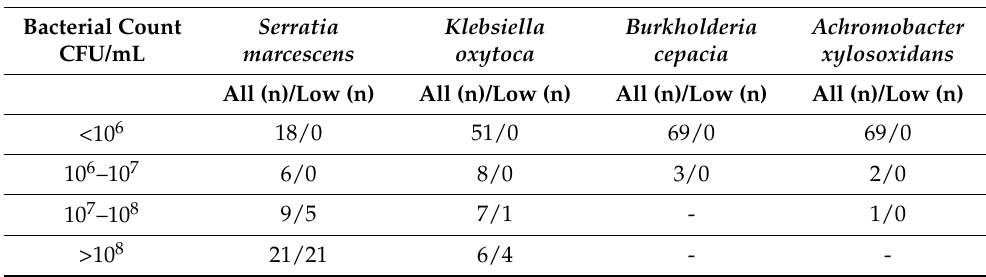
Table 2. Incidence of low-quality samples in relation to bacterial species and bacterial counts (CFU/mL) in extended semen during storage for 72 h in Beltsville Thawing Solution. Semen samples were spiked with four different multidrug-resistant bacterial species at ~10 3 CFU/mL and analyzed at 24, 48 and 72 h. Samples ( S. marcescens : n = 6; other bacteria: n = 7) were assigned to “low quality” if the difference to controls was > 10% for motility or > 2 for the agglutination score at a given bacterial count